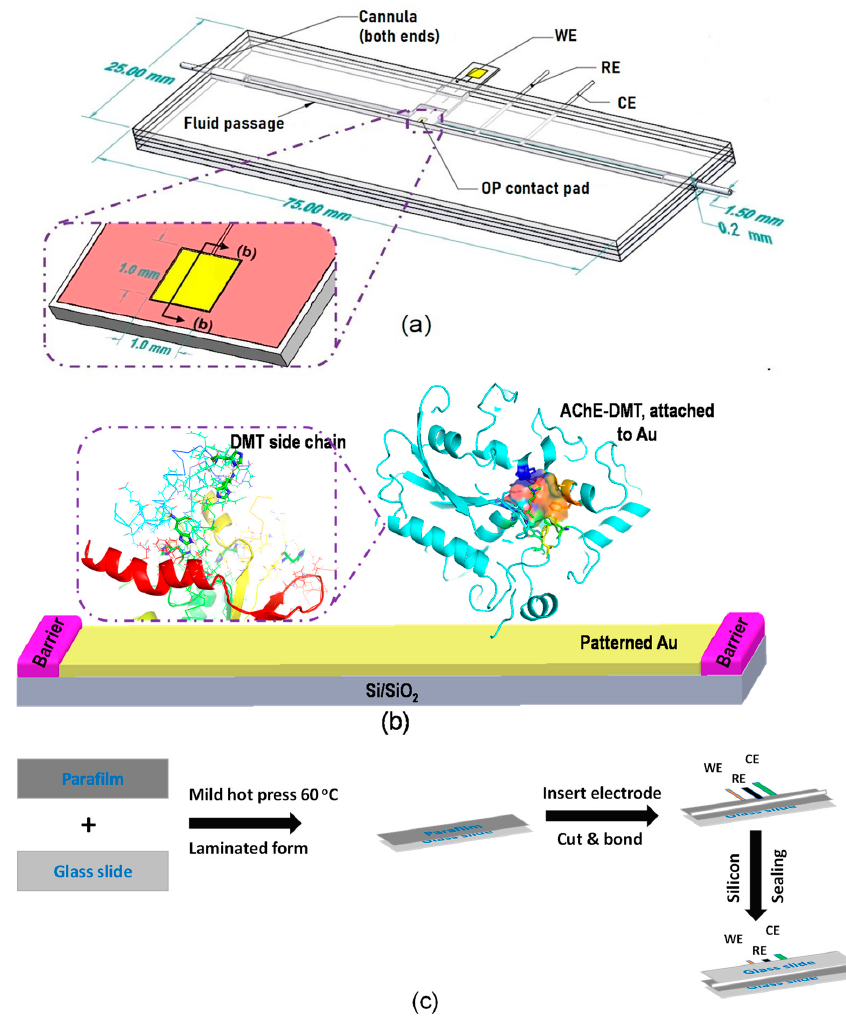
Figure 1. Schematic illustration for the biosensor development. ( a ) Three-electrode configuration is integrated into a fluidic chip for dimethoate (DMT) detection. Inset box is the working space (WE) where acetylcholinesterase (AchE) is immobi- lized. ( b ) Immobilization of AChE on working electrodes. AChE shows active sites and DMT molecules occupy the active sites to inhibit AChE activity. ( c ) Schematic of preparation steps for making channels for flow